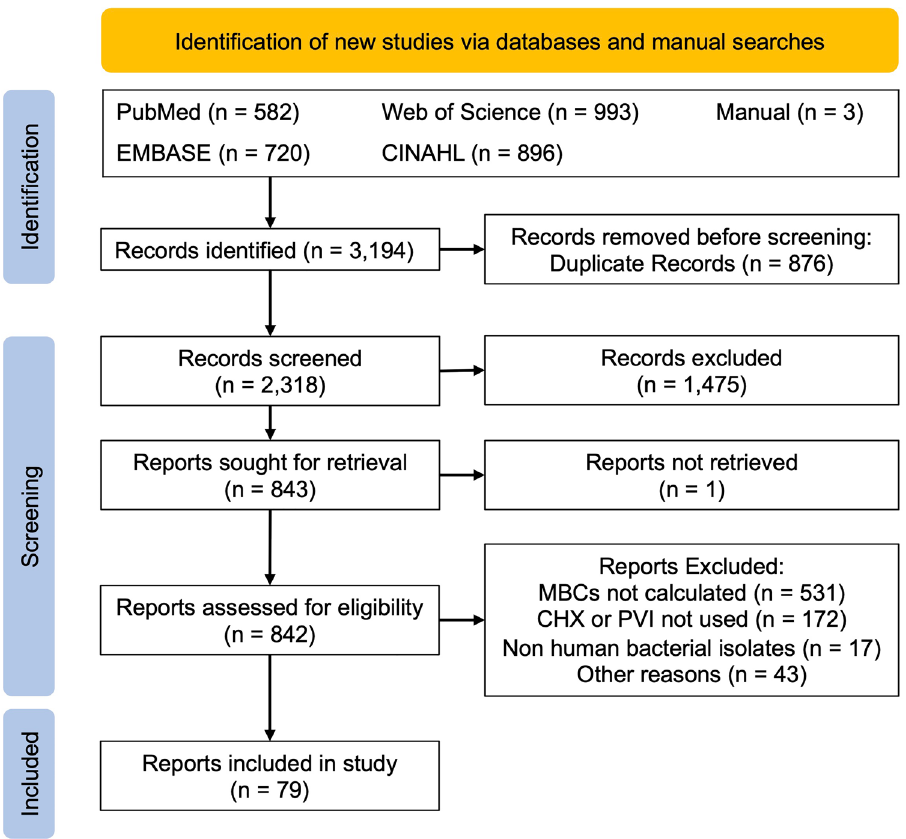
Figure 1. PRISMA flowchart—the following studies were excluded from the systematic review: (1) no MBC calculated, (2) use of biocide and alcohol mixtures, (3) use of non-human bacteria, (4) use of dental preparations of biocides, (5) no data on the strength of biocide